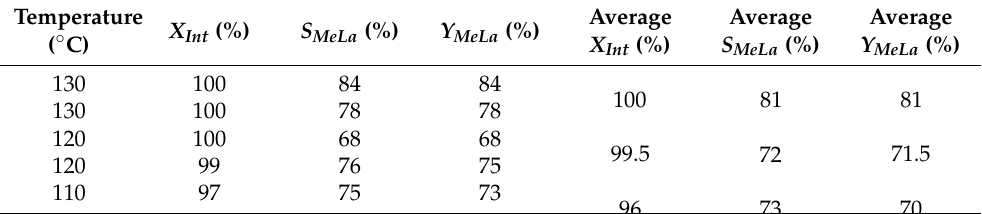
Table 3. PLA methanolysis at 600 rpm with 2 mol% ZnAc. Conversion of Int groups, MeLa selectivity and MeLa yield was calculated at 60 min for different reaction